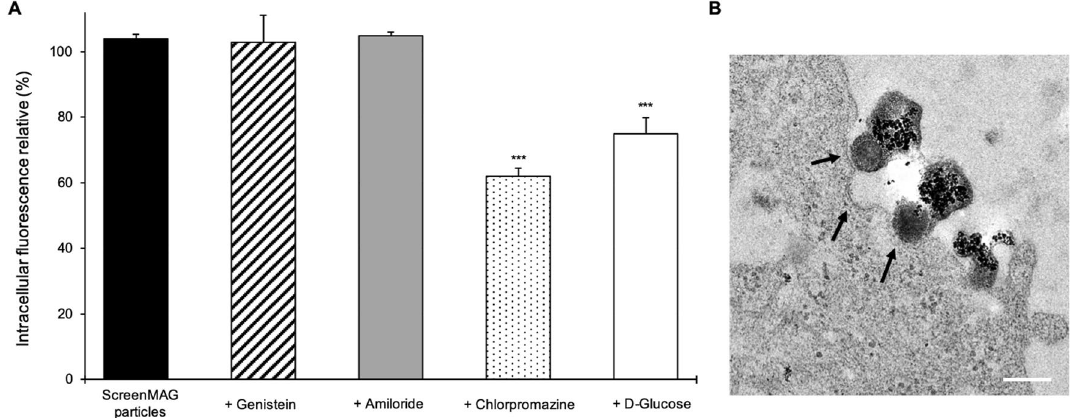
Figure 3. Internalization pathway of ScreenMAG particles in U87-MG cells. ( A ) Intracellular fluorescence analysis of iron oxide particles internalization within U87-MG cells treated with various chemical inhibitors (300 μM, 10 nM, 20 μM and 5 μM for genistein, amiloride, chlorpromazine and d-glucose, respectively) preventing different pathways of endocytosis. ***Significantly different from control ( P ≤ 0.01). ( B ) Transmission electron microscopy image of a cell after 4 h of incubation with the iron oxide particles. Vesicles resembling to clathrin coating pits (dark arrows) are observed. Scale bar: 200